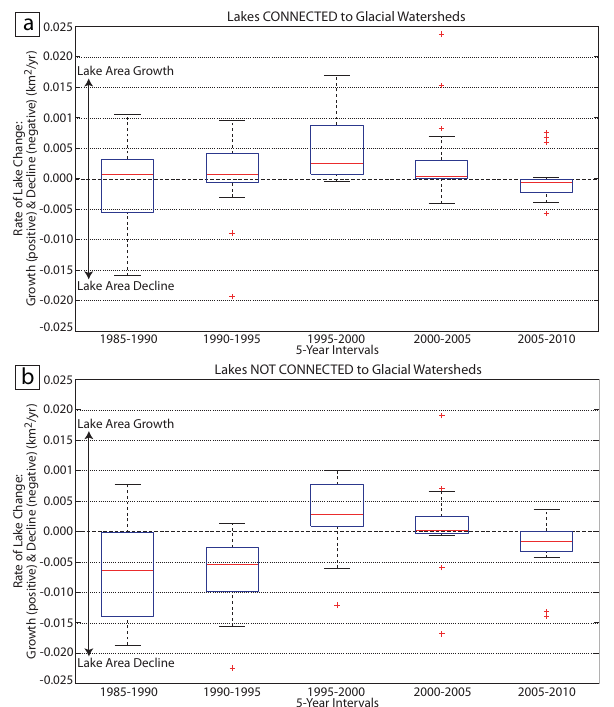
Fig. 17. Rate of lake-area changes within 5year time intervals for (a) lakes connected to glacial watersheds, and (b) lakes not con- nected to glacial